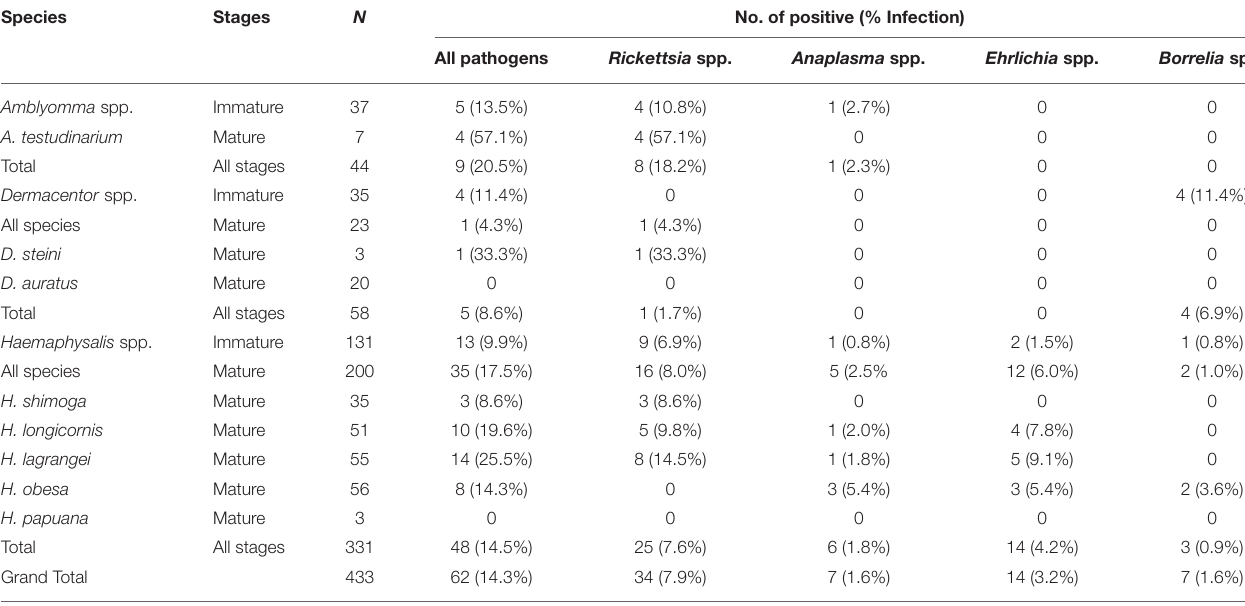
TABLE 2 | Prevalence of pathogenic bacteria ( Rickettsia spp., Anaplasma spp., Ehrlichia spp., and Borrelia spp.) in questing ticks from Khao Yai National Park, by species and stages. Species Stages N No. of positive (% Infection) All pathogens Rickettsia spp.